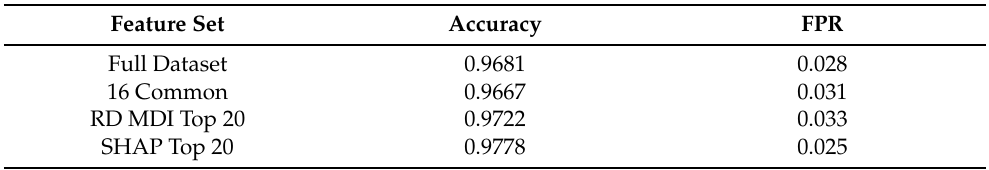
Table 6. Tabulated data for the accuracy and FPR using the full dataset, 16 common features, RF MDI top 20, and SHAP top 20